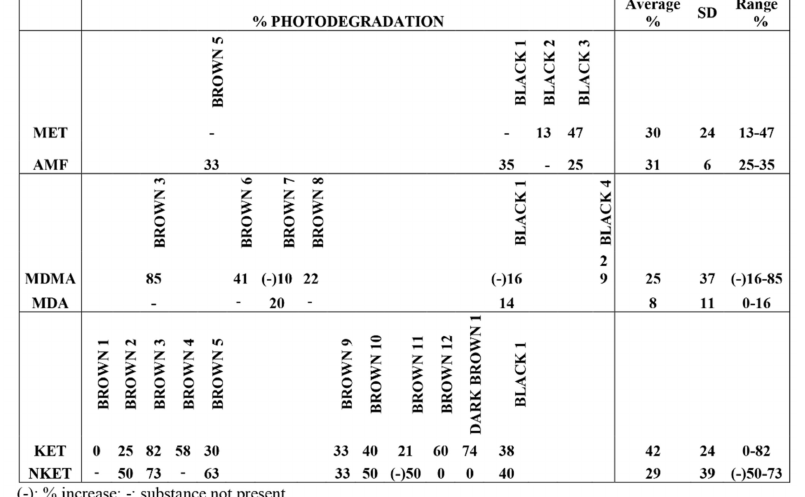
Figure 6. Percentage of photodegradation, average, standard deviation, and range of drugs in hair samples irradiated at 765 W/m 2 in the solar